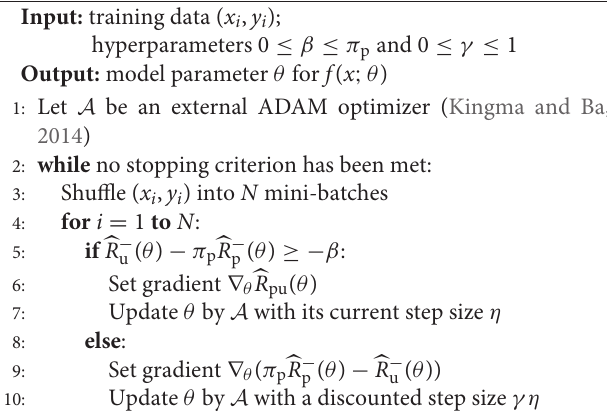
Algorithm 1: Optimization of Our 3D-BoxSup segmentation